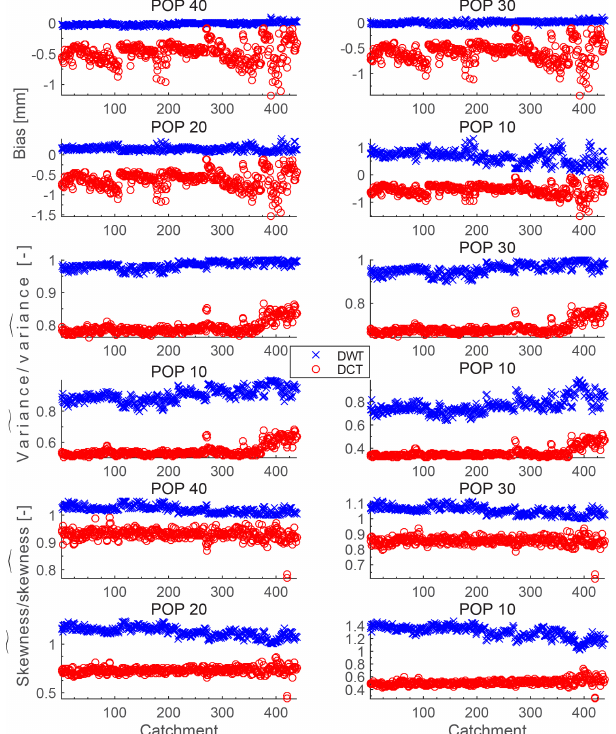
Figure 5. Bias and normalized variance and skewness of the recon- structed DWT and DCT signals for each catchment using a different POP.